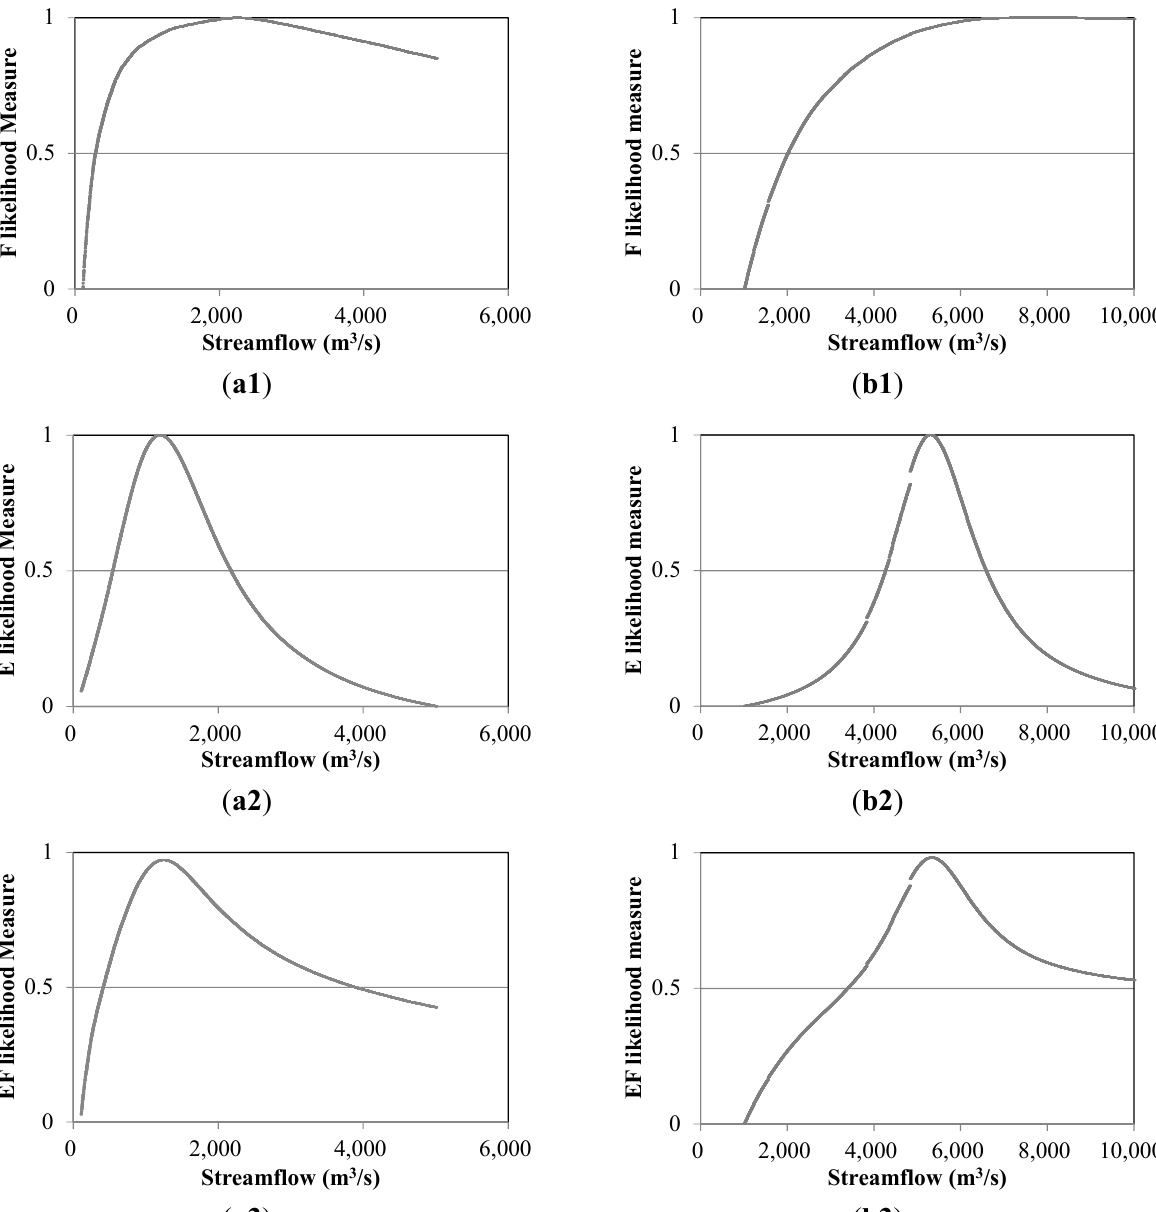
Figure 6. PDFs of discharge based on the rescaled likelihood measure. F